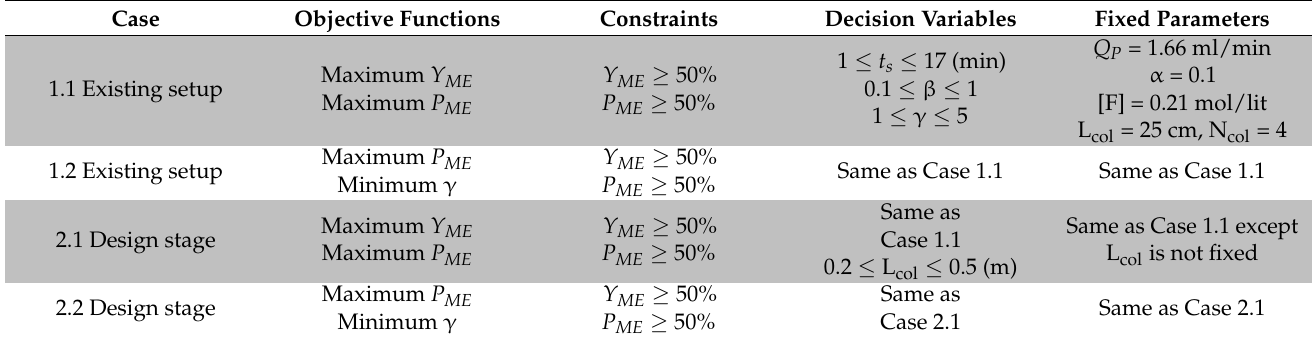
Table 1. Optimisation problems along with their objective functions, constraints, decision variables and fixed parameters.